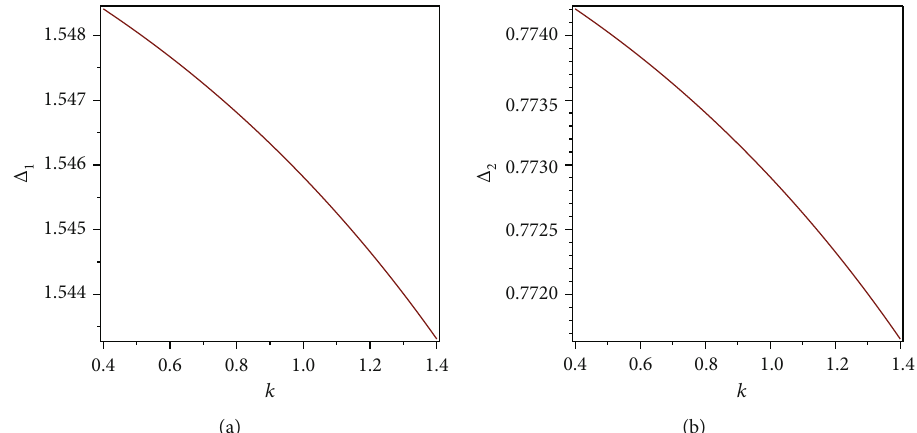
= 1 (a) and for large soliton k = 2 1 2